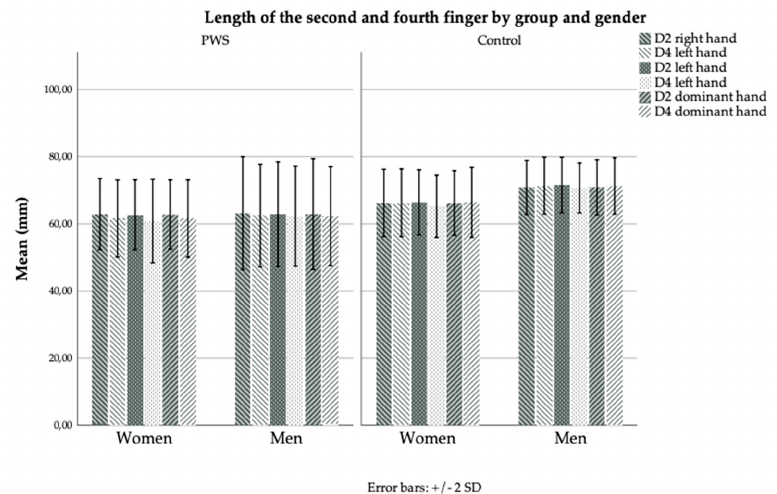
Chart 1. Characteristics of 2D and 4D fingers lengths by group (PWS participants vs. controls) and by gender.